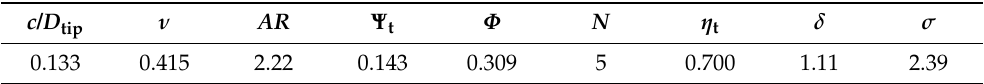
Table 3. Geometrical and material parameters of the blade for the PVS-affected rotor.